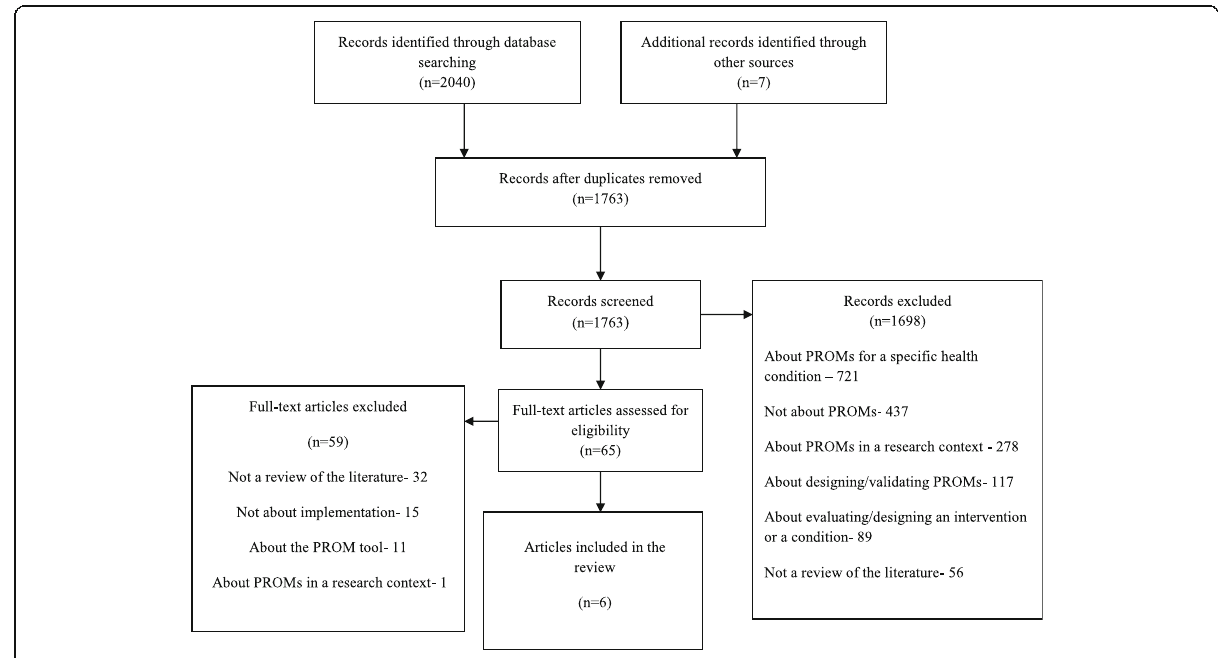
Fig. 1 PRISMA Statement for the systematic review of